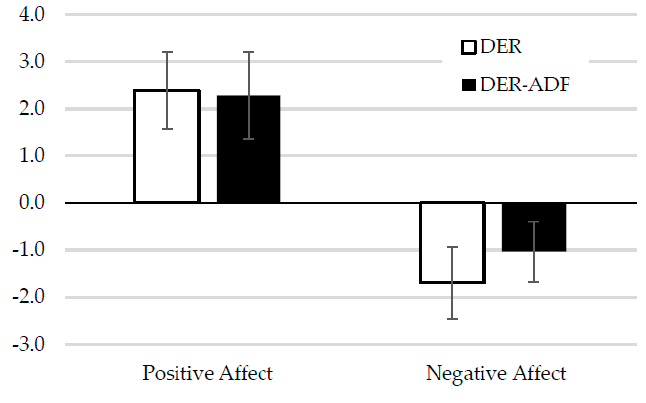
Figure 6. Changes in mood (positive and negative affect) presented by dietary allocation. Note: Scores based on the Positive and Negative Affect Schedule with a range from 10 to 50 with higher scores representing higher levels of positive or negative emotions. DER, ( n = 68) standard meal replacement program; ADF + DER ( n = 67) modified meal replacement program. For between-group differences, p > 0.05; for time effect p < 0.01 for decrease in negative affect and p < 0.001 for increase in positive affect; the interaction effect was p > 0.05, using linear mixed-effects model analysis.